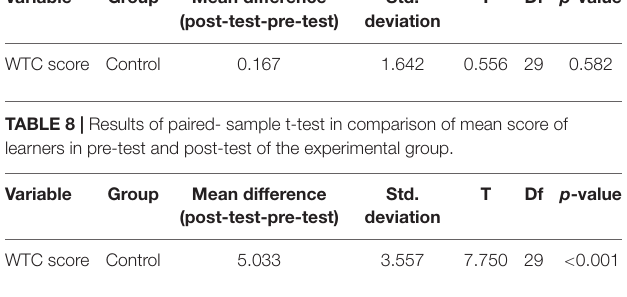
TABLE 6 | Average score of learners in both groups in pre-test and post-test. WTC score Pretest